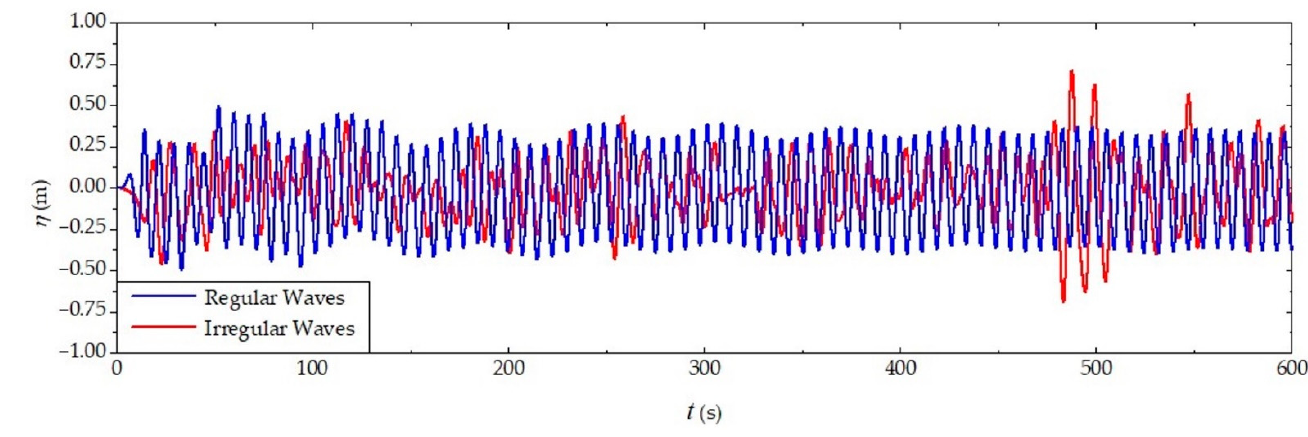
Figure 10. Free-surface elevation obtained with representative regular waves and realistic irregular waves for RG.